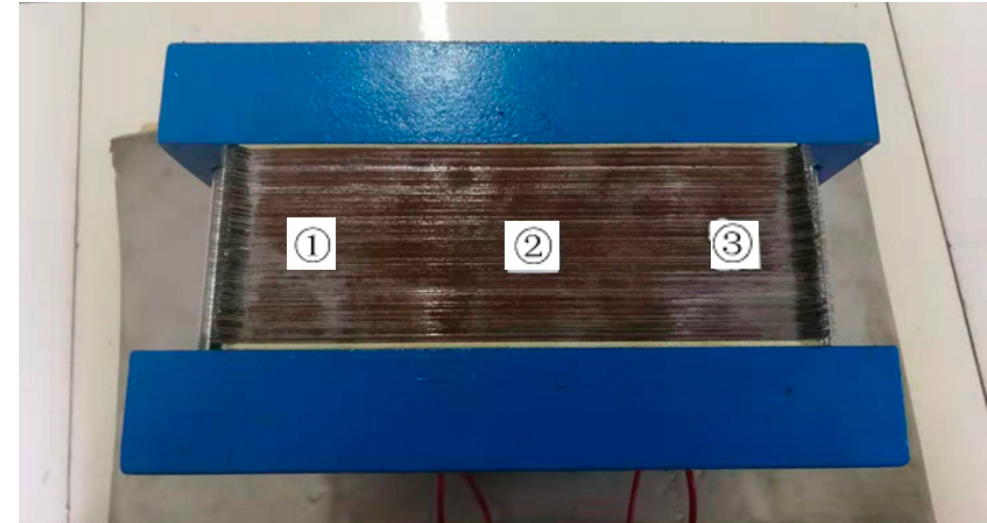
Figure 4. Distribution of vibration displacement measuring